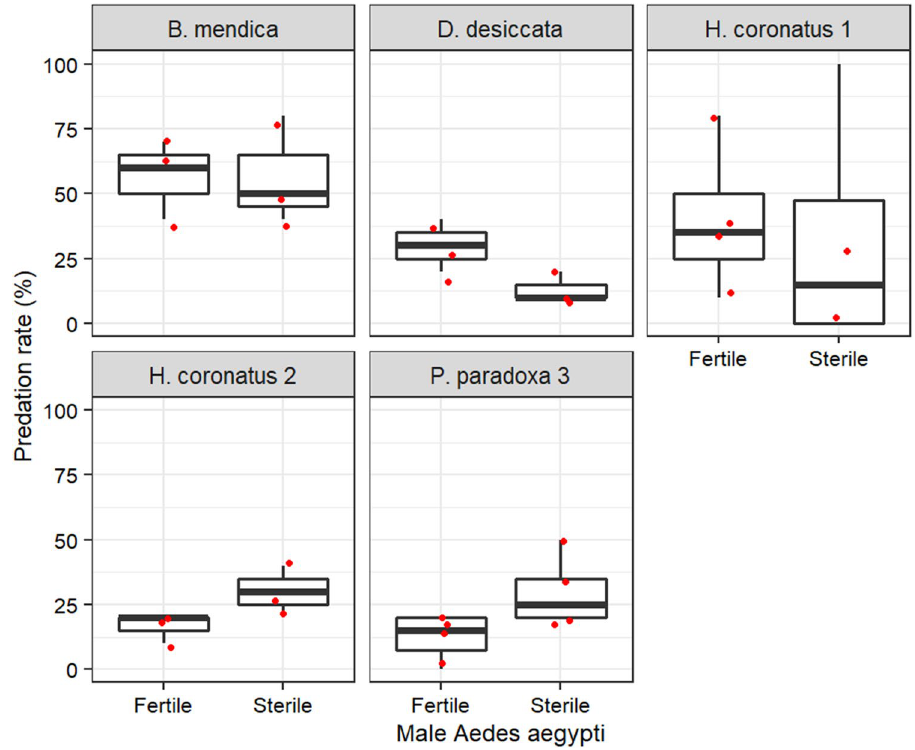
Figure 2. Vulnerability of fertile versus sterile male Aedes aegypti (irradiated at 70 Gy) to mantis predation.